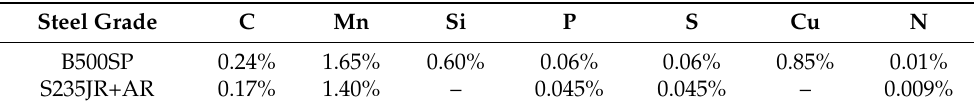
Table 1. Maximum content of elements in the chemical composition of two tested steel grades B500SP and S235JR+AR.